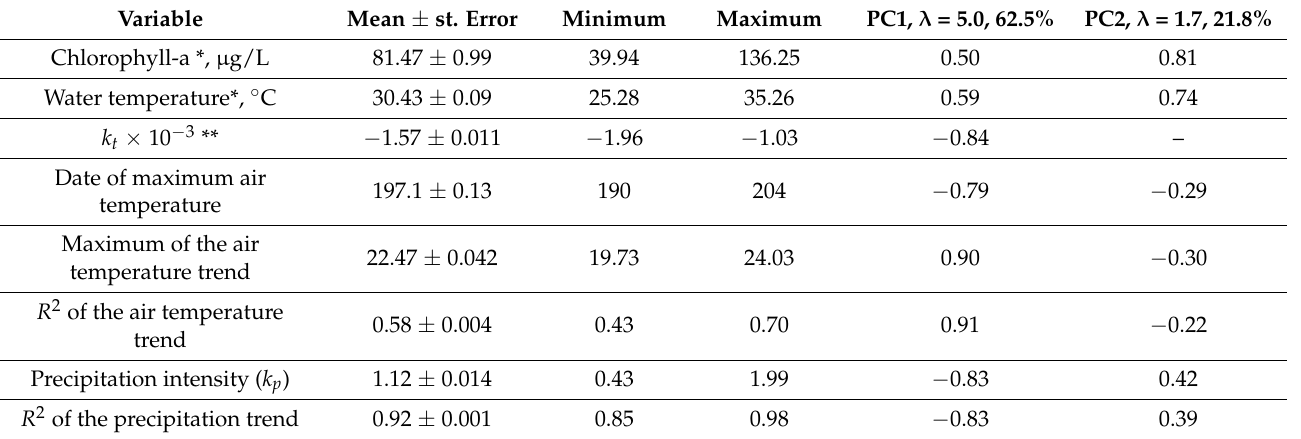
Table 1. Descriptive statistics of the environmental explanatory variables ( n = 570) and results of the principal component analysis (only statistically significant correlation coefficients of the principal components and variables are presented for p <